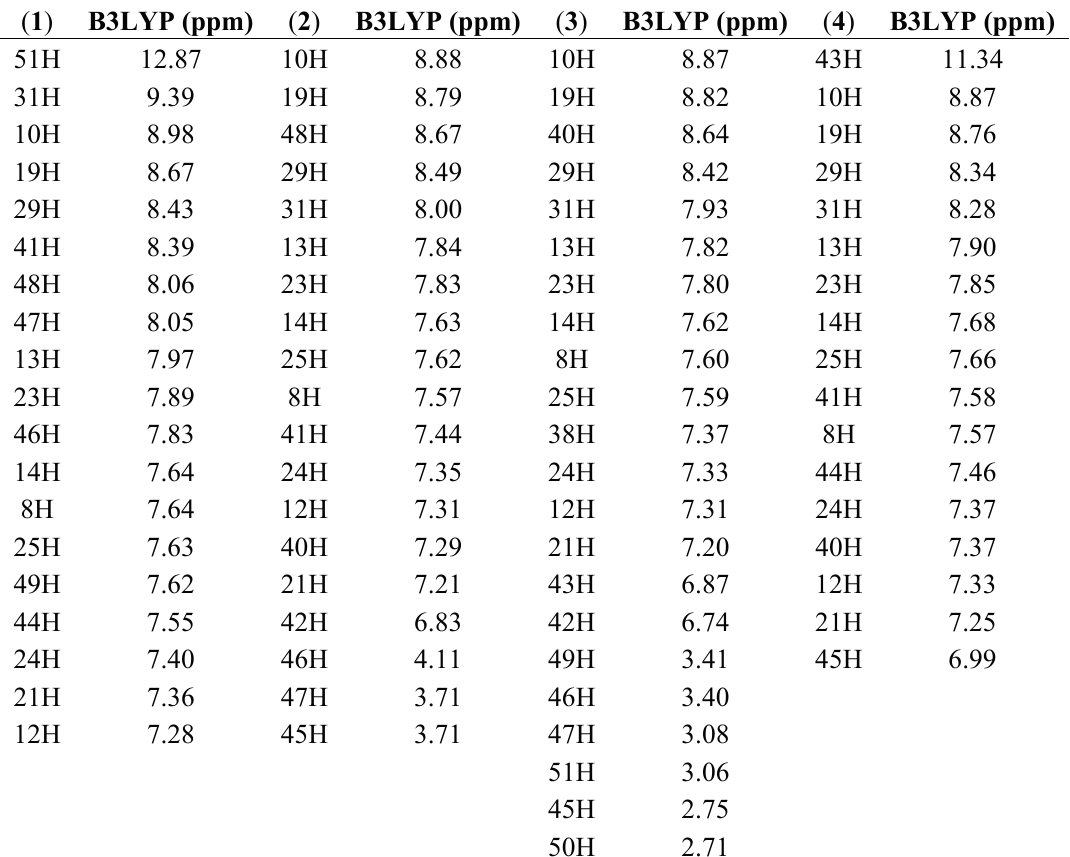
Table 8. Simulated 1 H-NMR chemical shifts of 1 – 4 (ppm) at B3LYP/6-311+G (2d, p) level (atomic labels are with reference to Figure